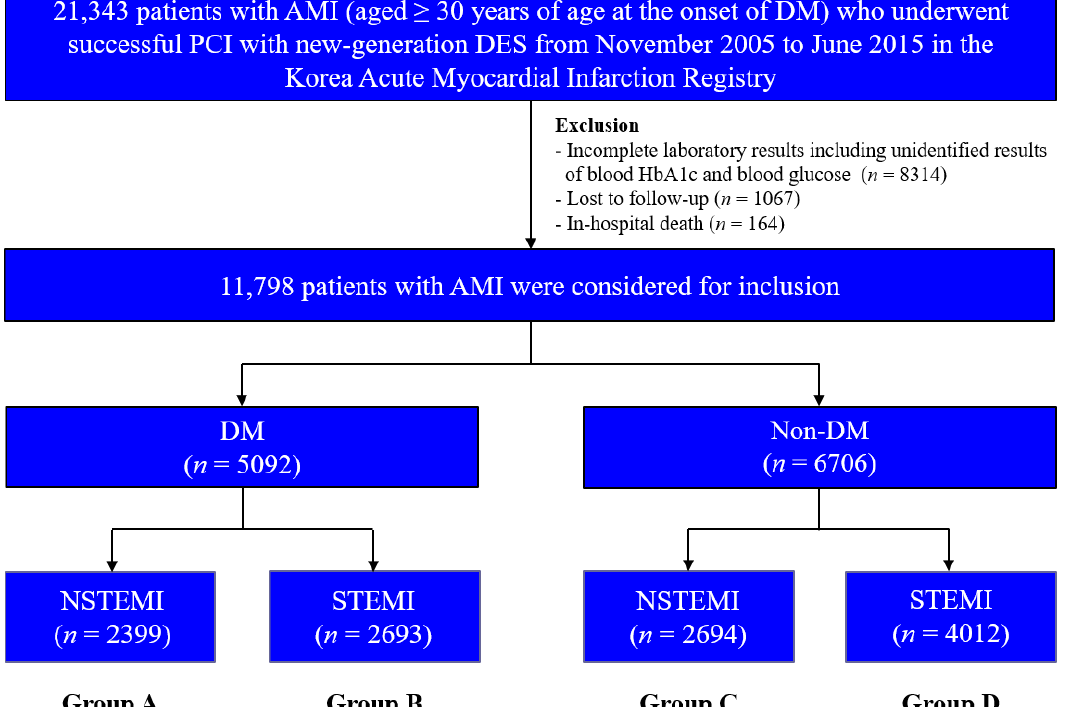
Figure 1. Flowchart. AMI, acute myocardial infarction; DM, diabetes mellitus; DES, drug-eluting stent; Hb, hemoglobin; NSTEMI, non-ST-segment elevation myocardial infarction; STEMI, ST-segment elevation myocardial infarction.